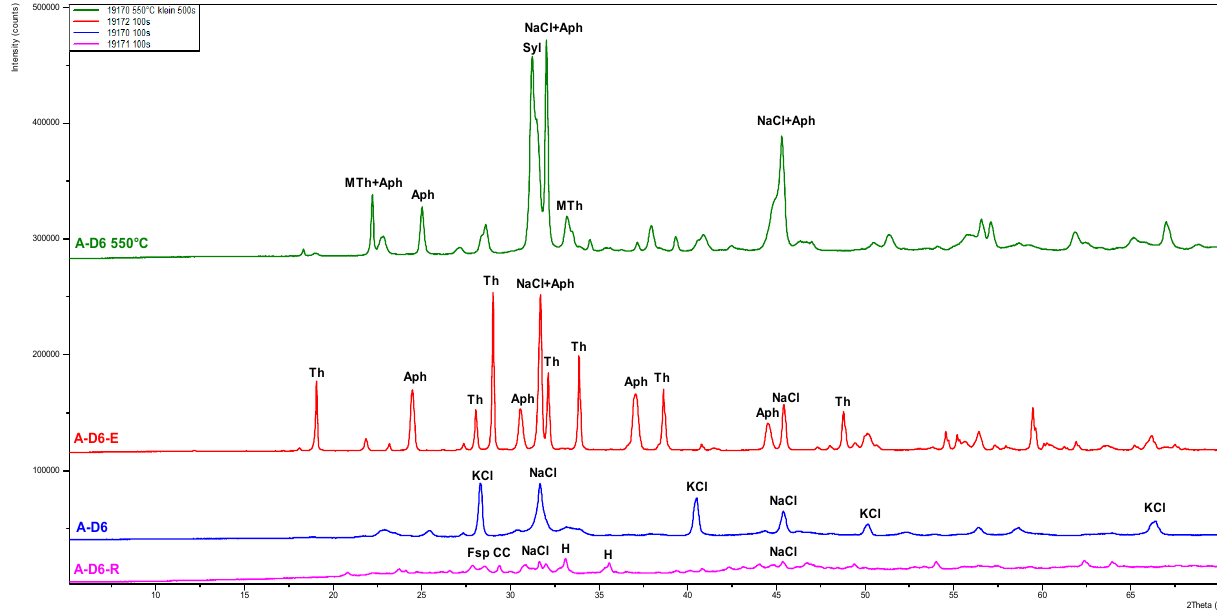
Table 3. Comparison of MEROS dust samples data in the literature.